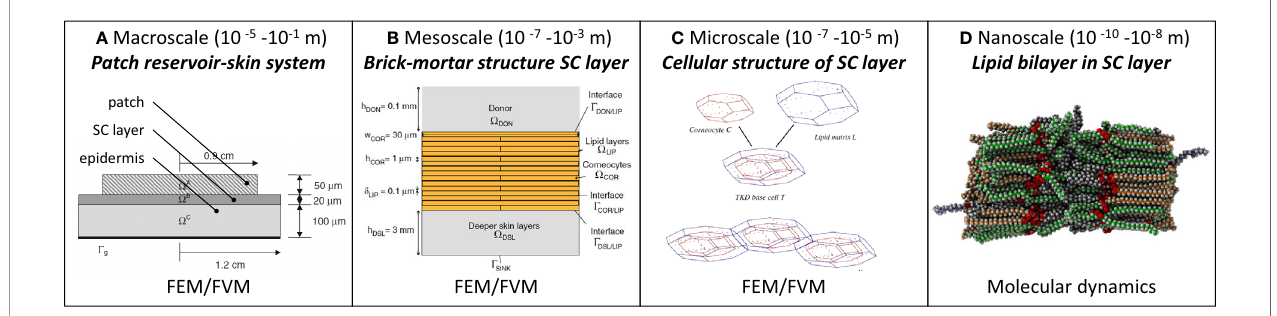
FIGURE 1 | Overview of existing mechanistic models [adapted from (A) (Rim et al., 2009), (B) (Selzer et al., 2013), (C) (Naegel et al.,